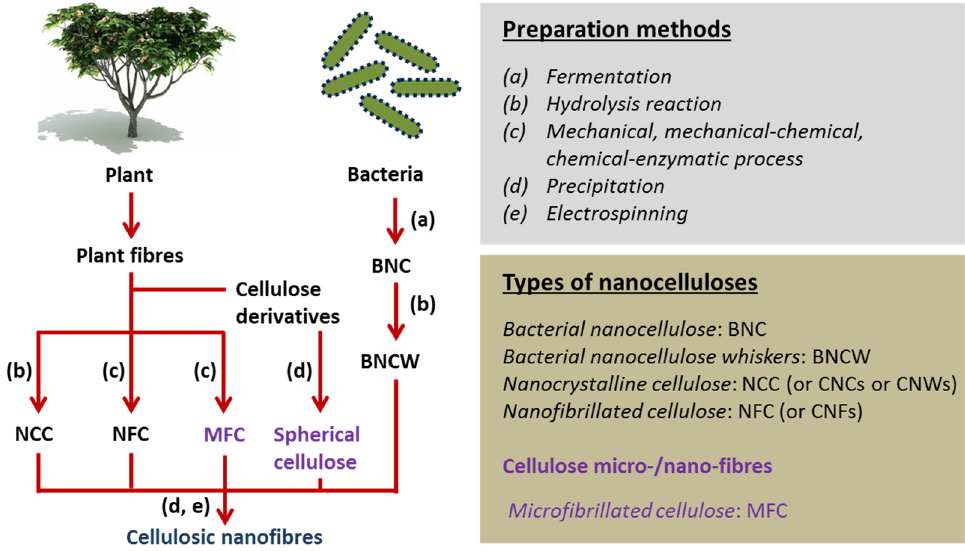
Figure 1. Schematic representation of the sources, preparation methods, and classification of nanocelluloses. Adapted from [14].